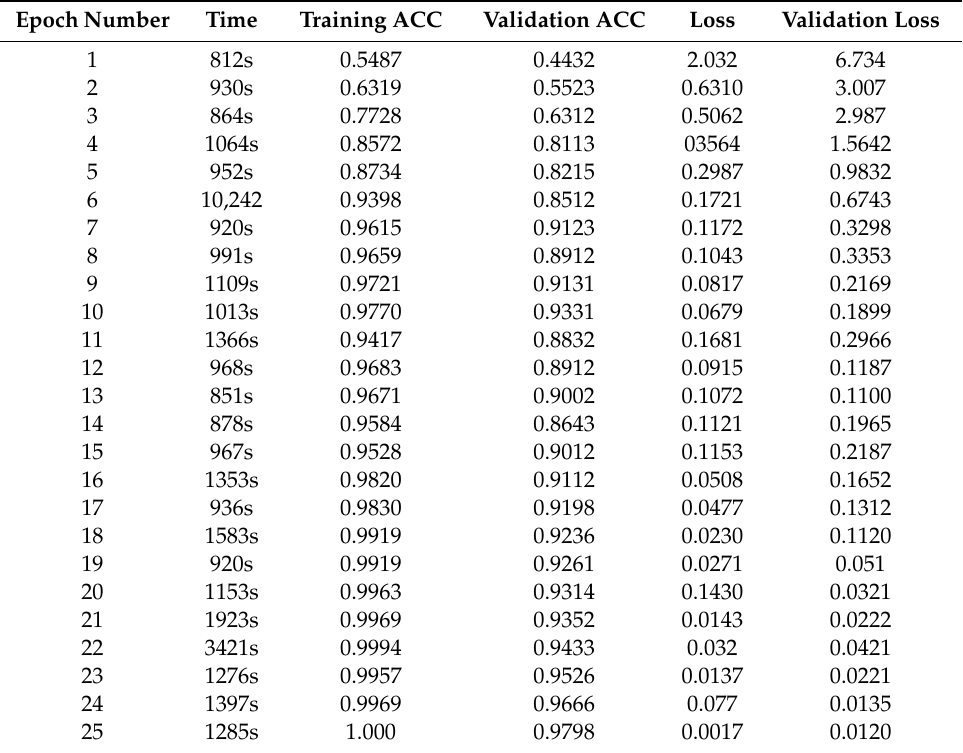
Table 5. Classification results based on training and validation dataset.